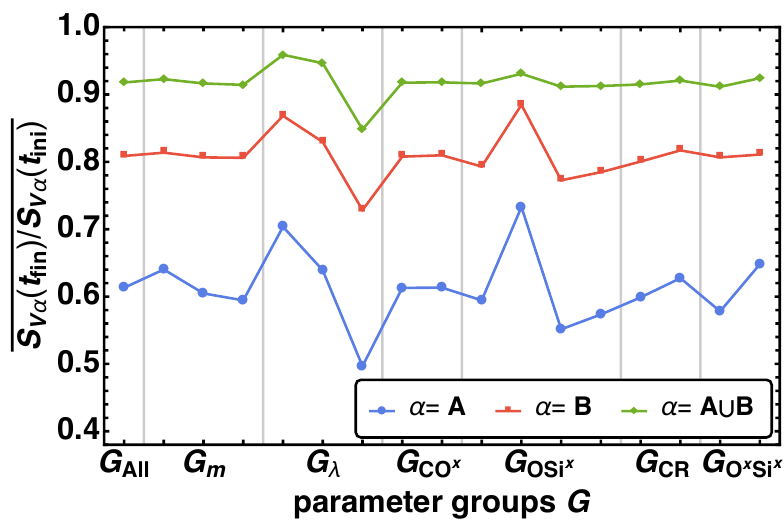
( t ) / S ( t ) is given for the parameter V α ini fin α